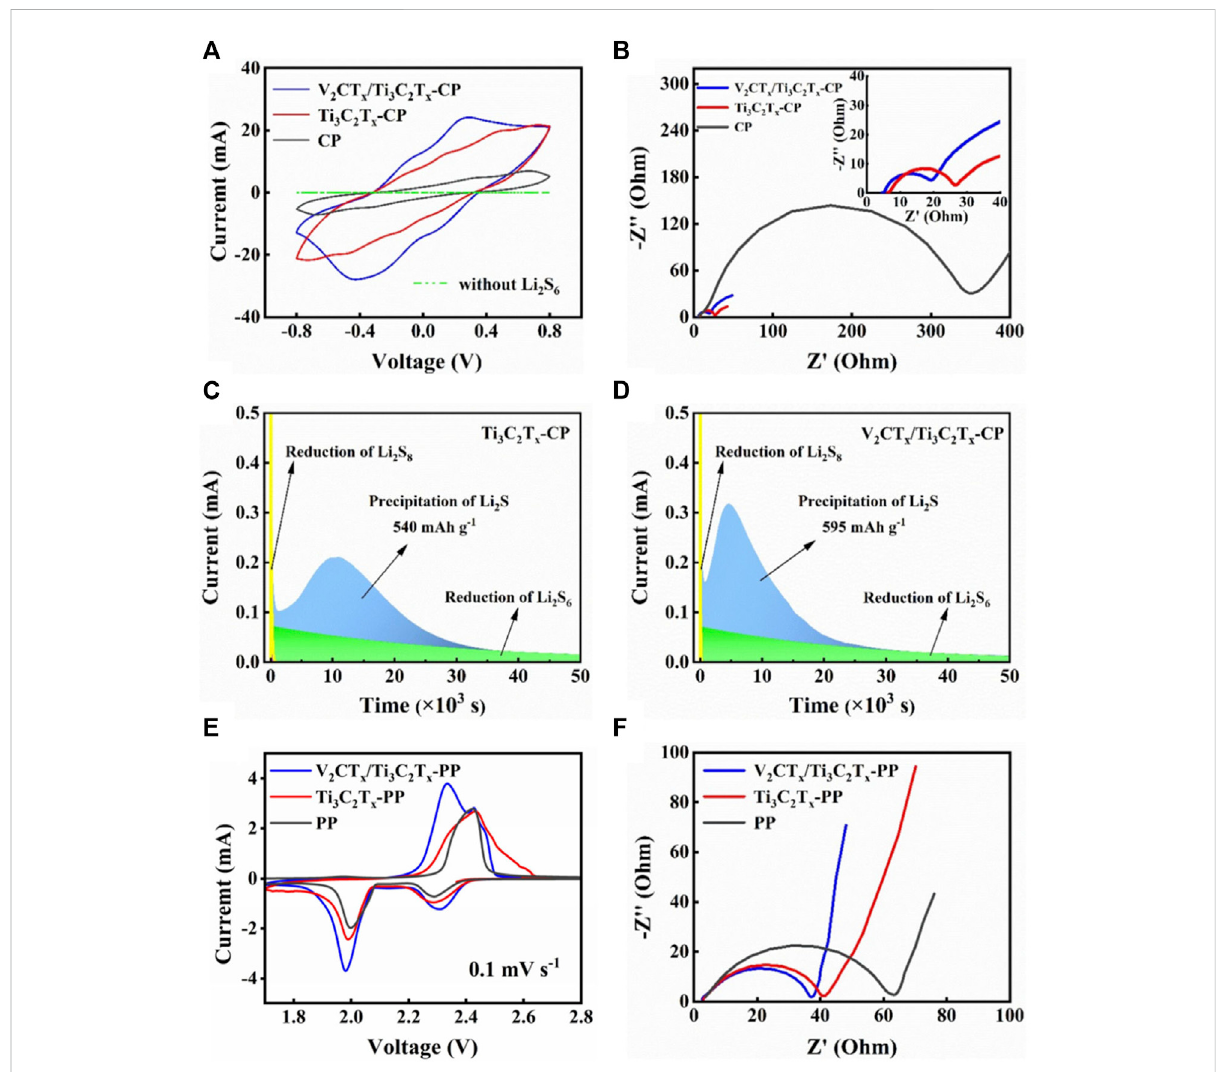
FIGURE 2 (A) CV curves of different symmetric cells under 50 mV · s − 1 and (B) EIS spectra of V 2 CT x /Ti 3 C 2 T x -CP, Ti 3 C 2 T x -CP, and CP symmetric cells using